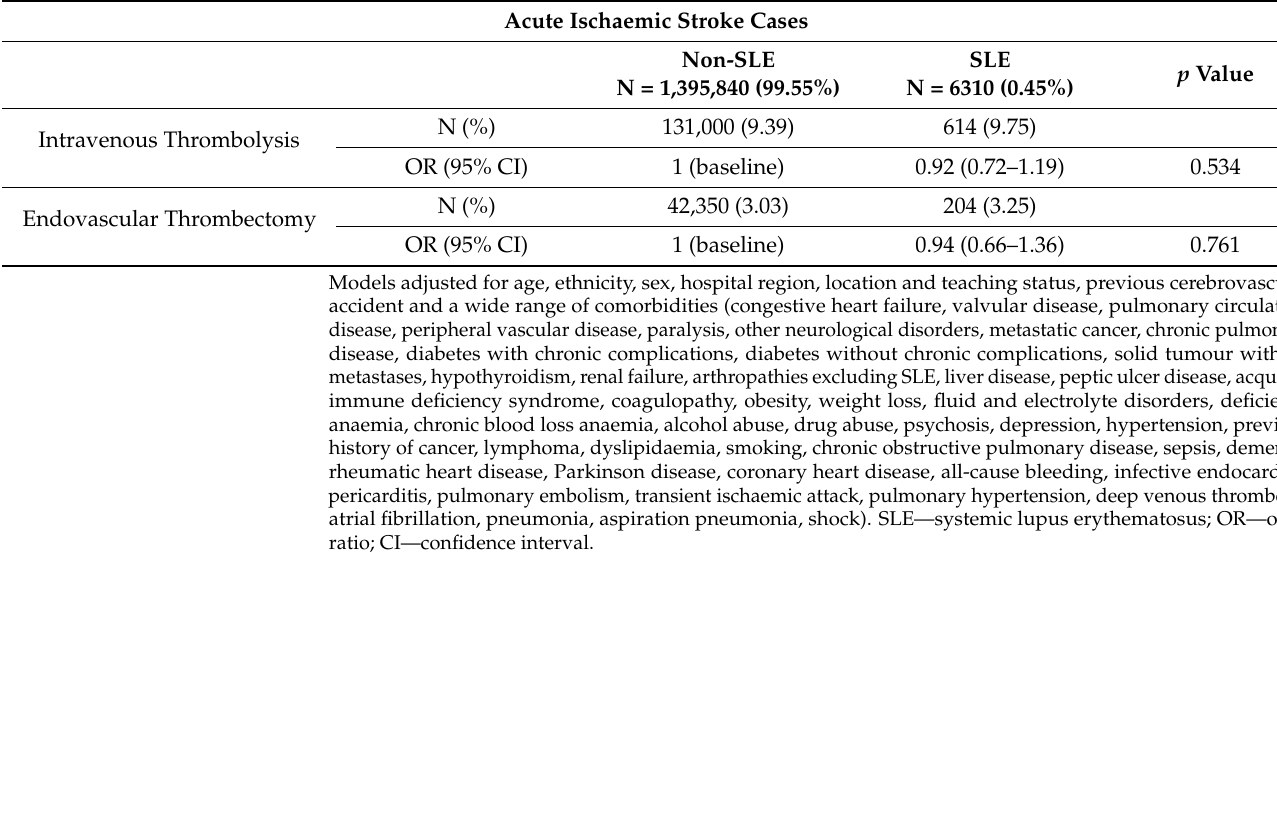
Table 3. Results of multivariable logistic regression assessing the association between co-morbid SLE and receipt of intravenous thrombolysis or endovascular thrombectomy amongst patients with ischaemic